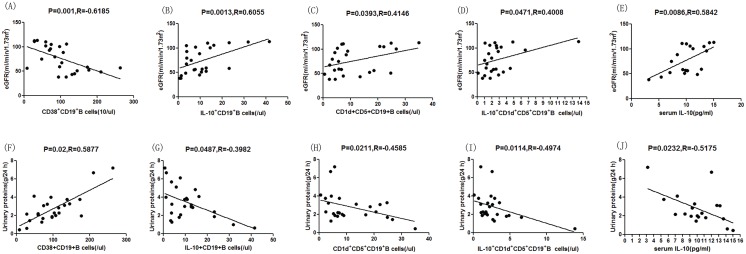
Correlation analysis of clinico-pathological features of HSPN patients, based on the percentages of CD19+ B cell subtypes.(A) The eGFR was negatively correlated with the number of CD38+CD19+ B cells. (B) The eGFR was positively correlated with the numbers of IL-10+CD19+ B cells, (C) CD1d+CD5+CD19+ B cells (D), and IL-10+CD1d+CD5+CD19+ B cells (E) as well as the serum concentration of IL-10. (F) The 24-h urinary protein concentration was positively correlated with the number of CD38+CD19+ B cells. (G) The 24-h urinary protein concentration was negatively correlated with the numbers of IL-10+CD19+ B cells, (H) CD1d+CD5+CD19+ B cells, and (I) IL-10+CD1d+CD5+CD19+ B cells as well as the (J) serum concentration of IL-10. The potential correlations among the numbers of B cells of different subsets, Bregs, and the values of clinical parameters were analyzed by the Spearman correlation tests.